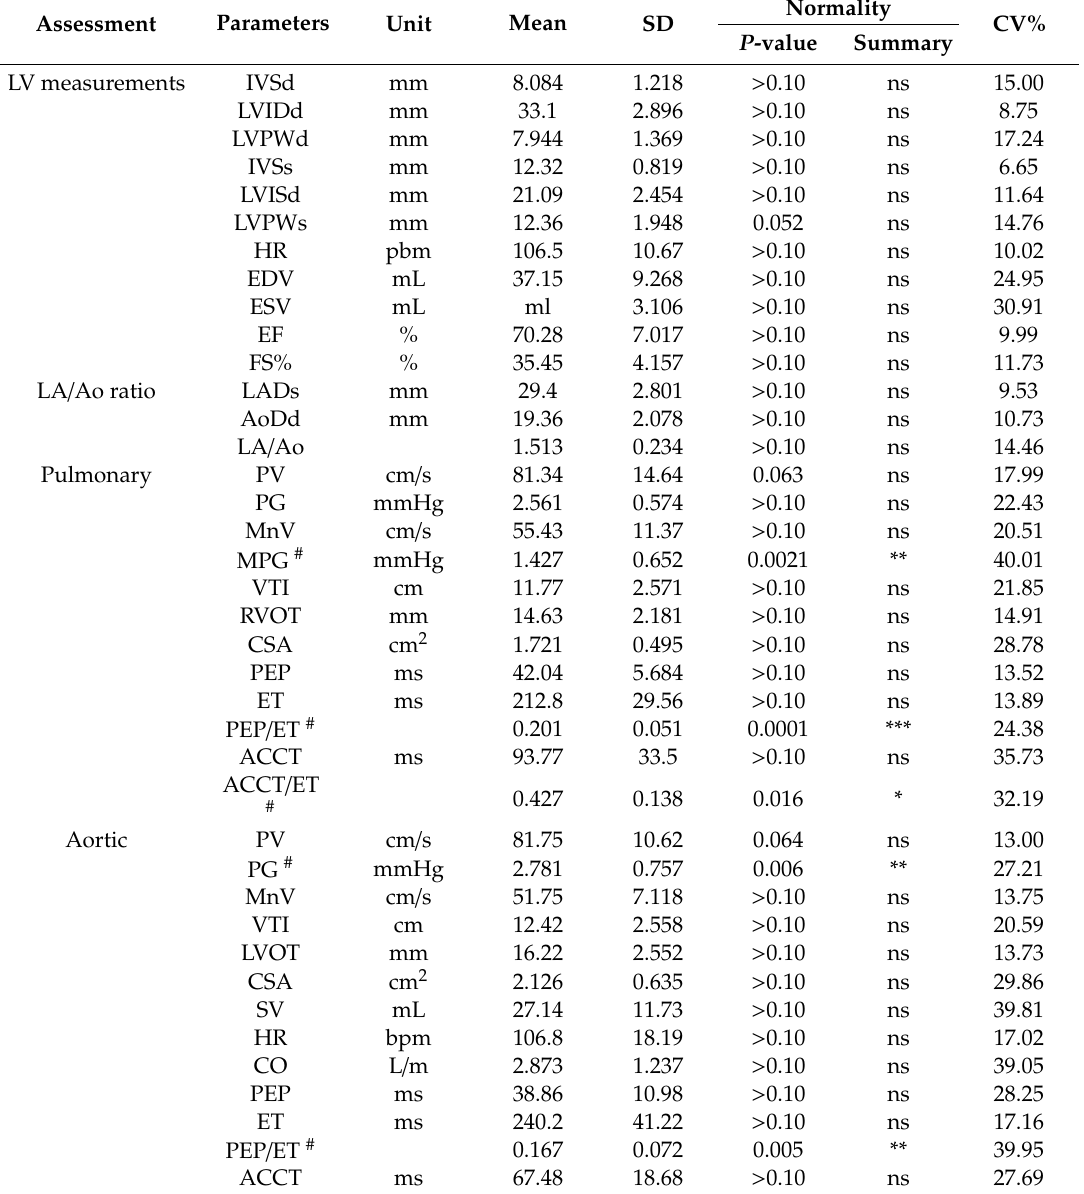
Table 1. Reference interval, normality, and variability of the full conventional echocardiographic measurements in male Shiba